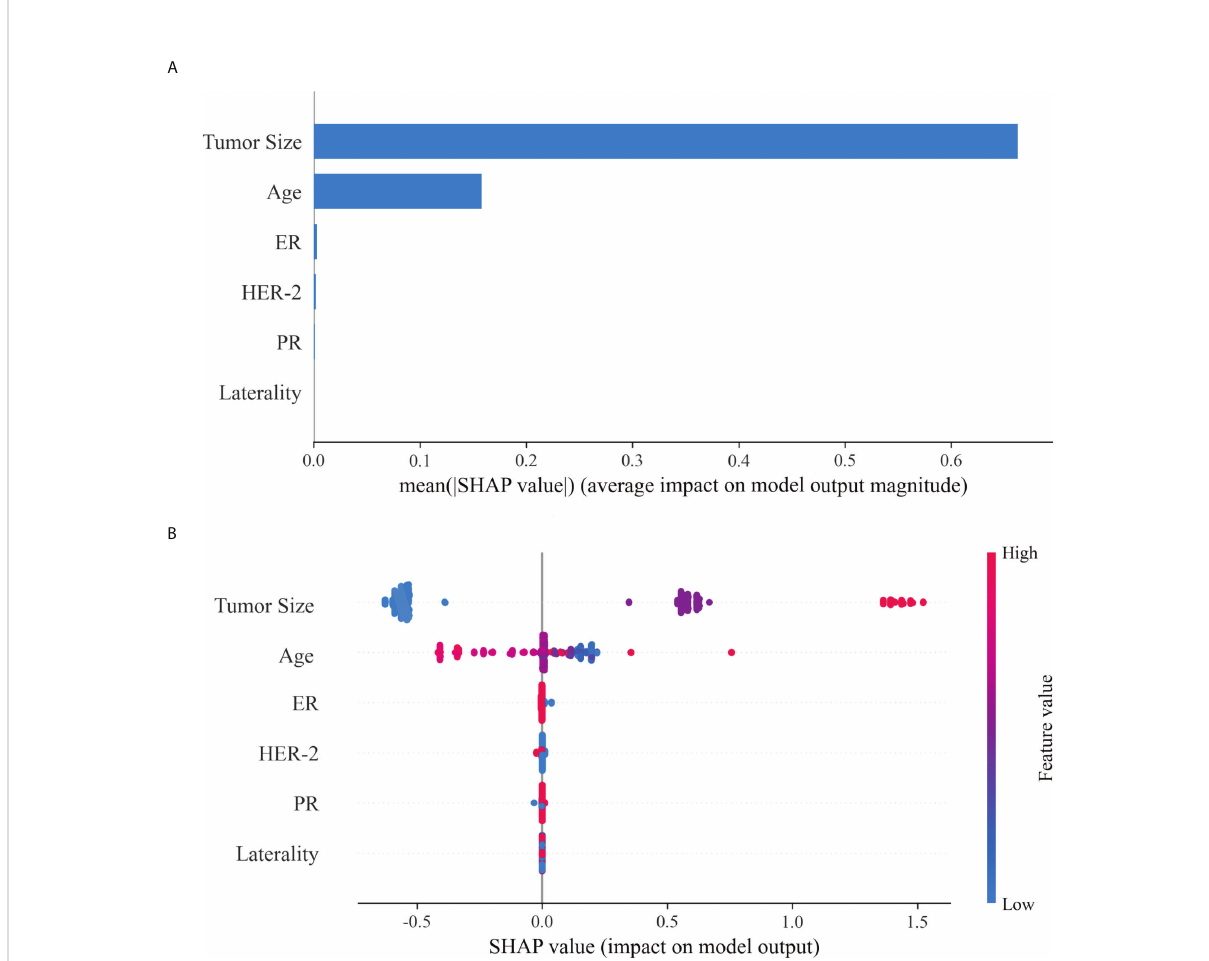
FIGURE 3 The interpretation of optimal model (Xgboost). (A) : The importance ranking of different variables according to the mean (|SHAP value|); (B) : The importance ranking of different risk factors with stability and interpretation using the optimal model. The higher SHAP value of a feature is given, the higher risk of lymph node metastasis the patient would have.The red part in feature value represents higher feature